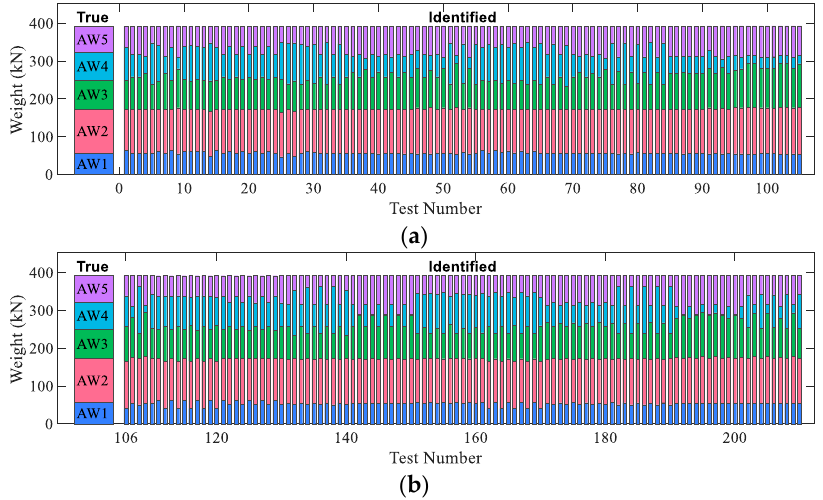
Figure 9. Identified axle weights of the 5-axle truck: ( a ) loading position 1 and ( b ) loading position 2. It should also be marked that all the results for the two loading positions (centers of the left lane and the right lane) were identified using the proposed method based on the